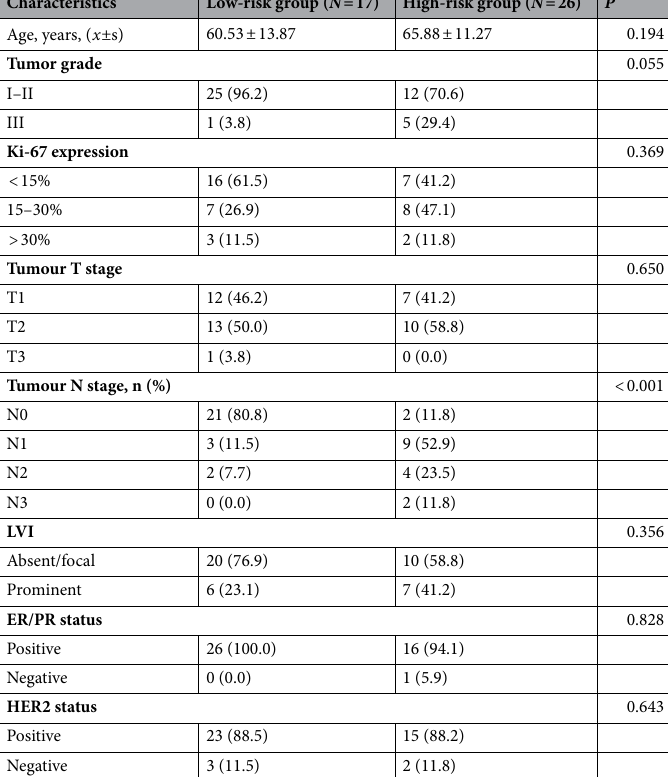
Table 2. Correlation between RI-LR and clinicopathological features, n (%). LVI lymphovascular invasion, ER/PR estrogen receptor/progesterone receptor, HER2 human epidermal growth factor receptor 2, RI-LR recurrence index for local